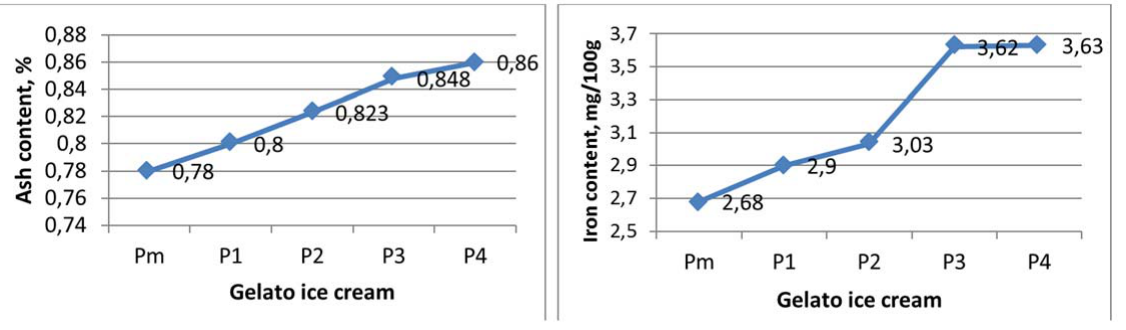
Figure 3. The effect of using spirulina on the iron content of